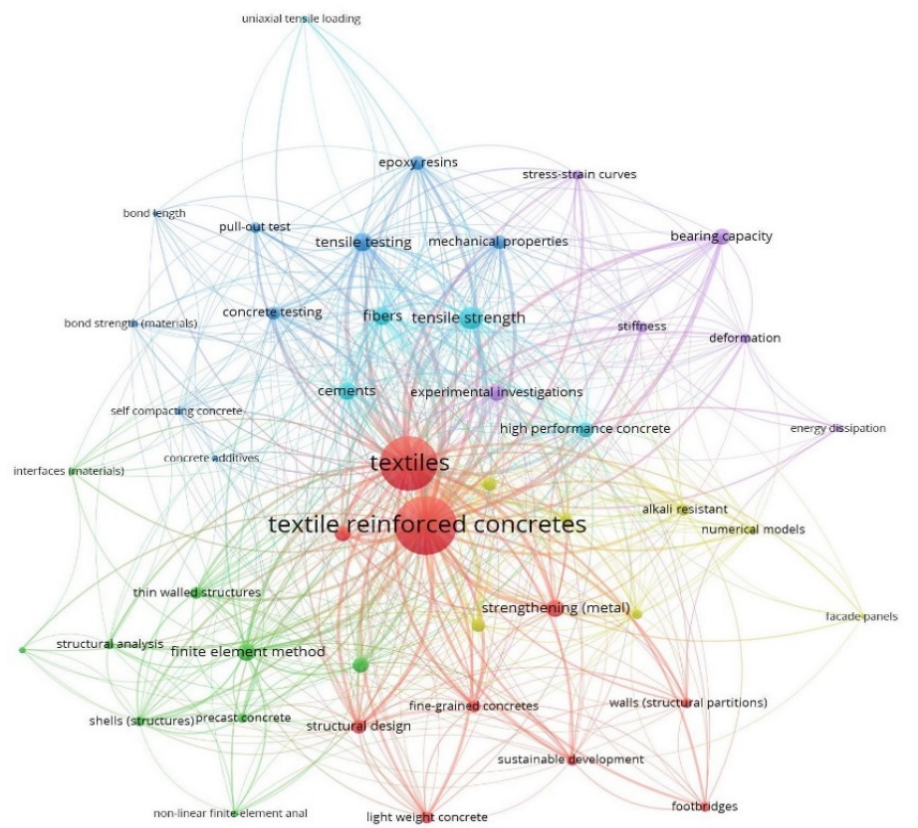
Figure 2. Co-occurrence of keywords in TRC research.